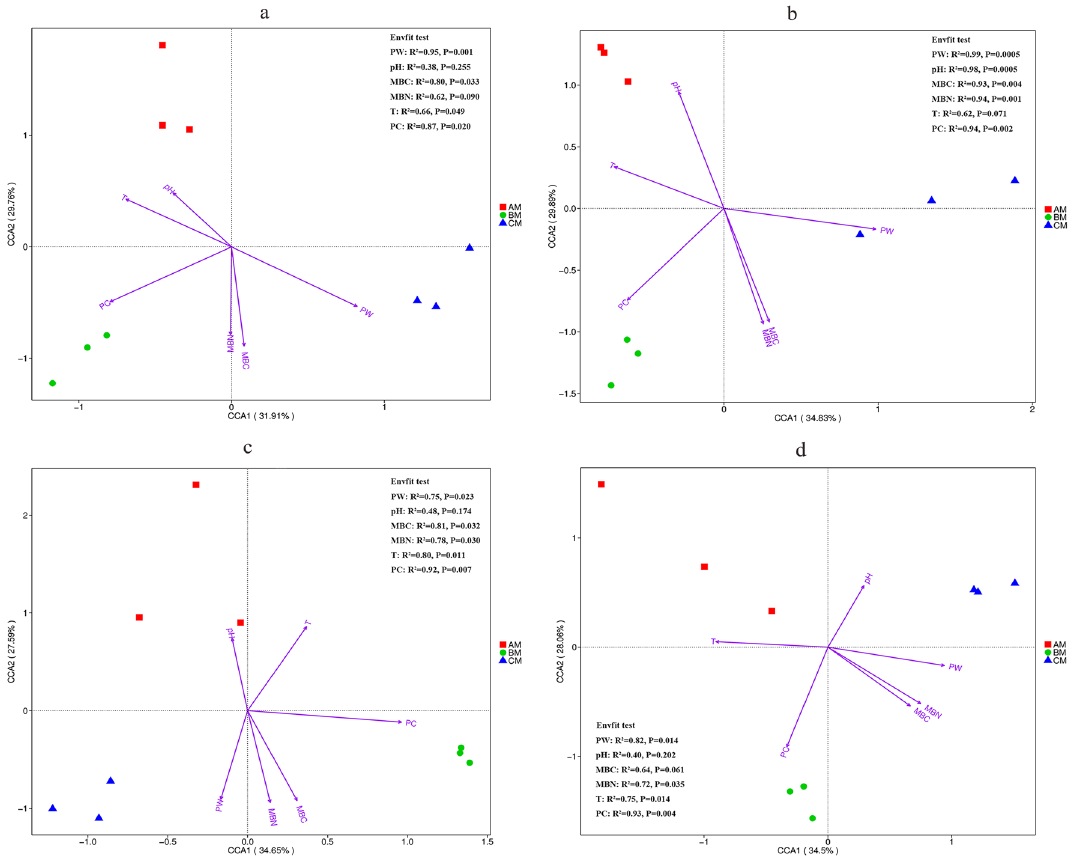
Figure 3. Canonical correspondence analysis between bacterial microbiota and ecological factors (PW, pH, MBC, MBN, T, and PC) in wheat-cultivated soils ( a ), astragalus-cultivated soils ( b ), potato-cultivated soils ( c ), and angelica-cultivated soils ( d ). AM, BM, and CM represented the different growth stages at 56 days, 98 days (AM), and 129 days respectively. In Envfit test results: R 2 , the coefficient of determination between factors and species distribution; P, the statistical